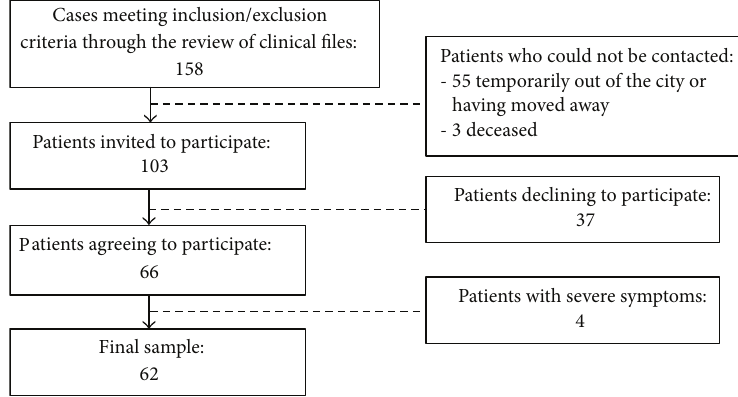
Figure 1: Flow of participant